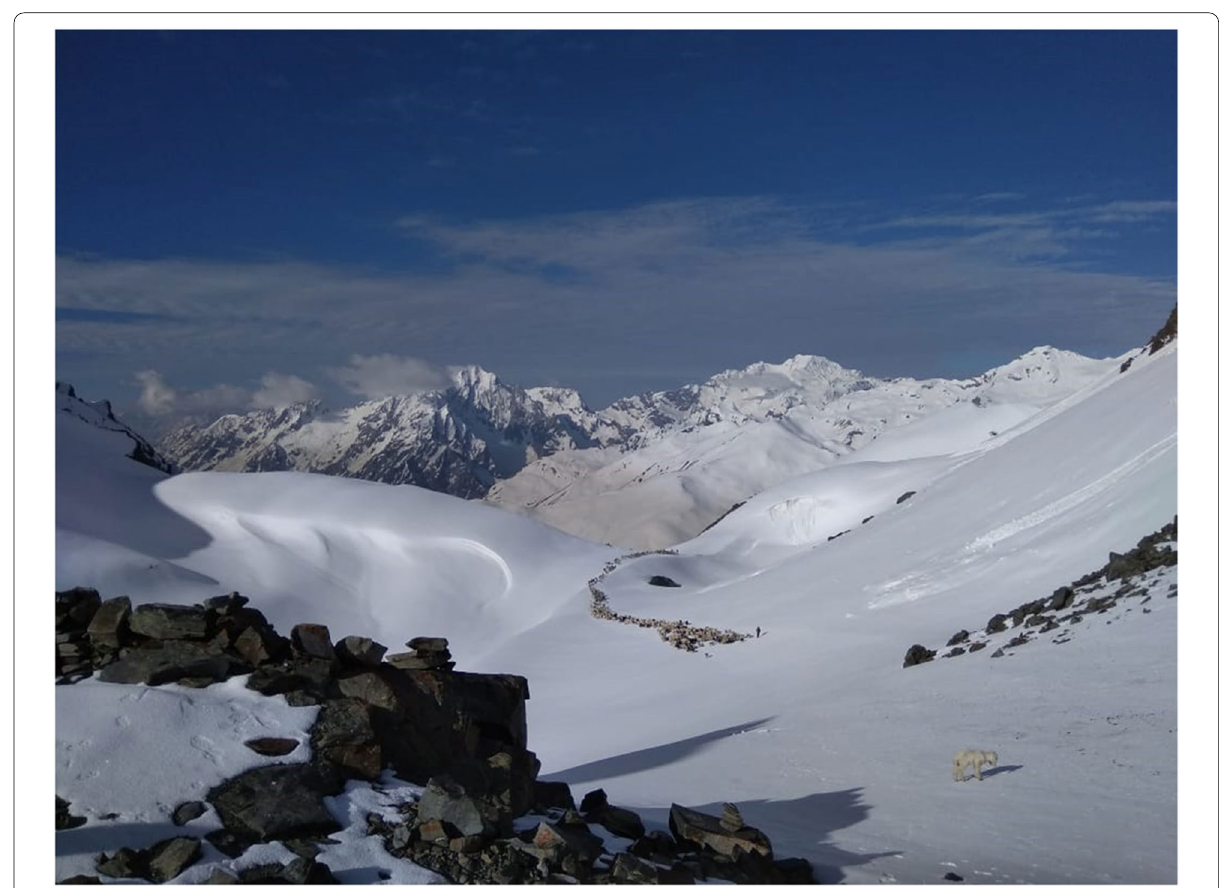
Fig. 2 A Kinnaura herder tol crossing the Bhaba pass from Rupi‑Bhaba into Pin valley. Some livestock do not make it across the pass, as seen by the lone goat kid left behind the